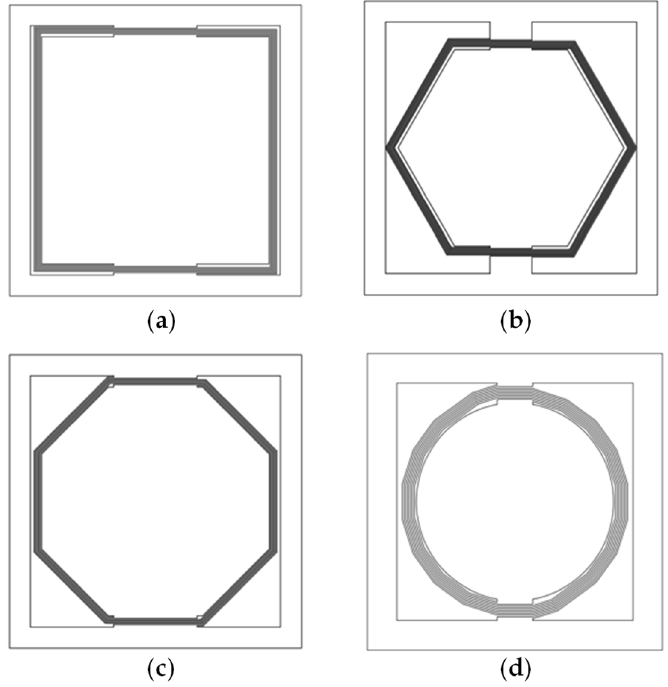
Figure 3. Top view of the different patterns of cantilever beams. ( a ) Square pattern; ( b ) regular hexagon pattern; ( c ) regular octagon pattern; ( d ) circle pattern.